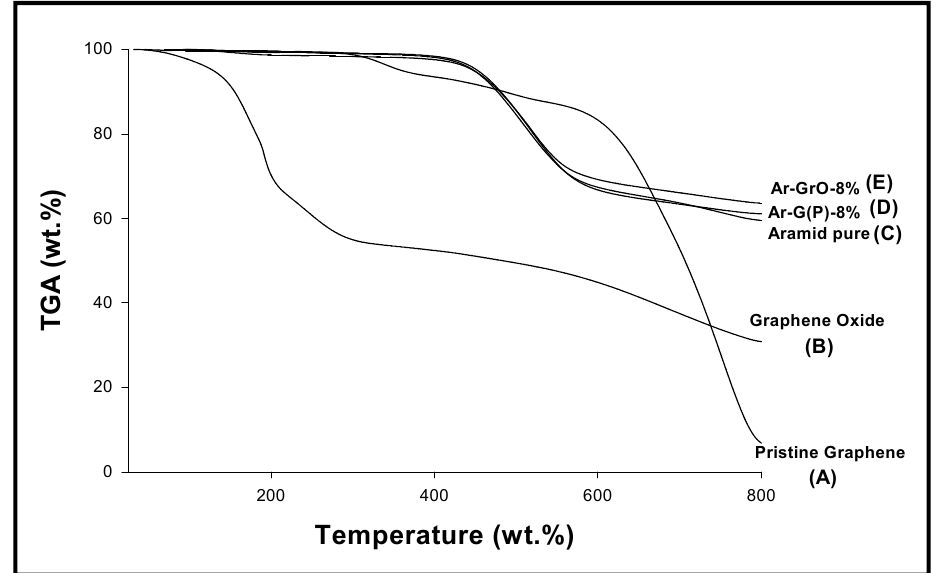
Figure 13. TGA Thermograms for Gr, GrO, Ar neat, ArGr and ArGrO films with 8 Wt.% Graphene.